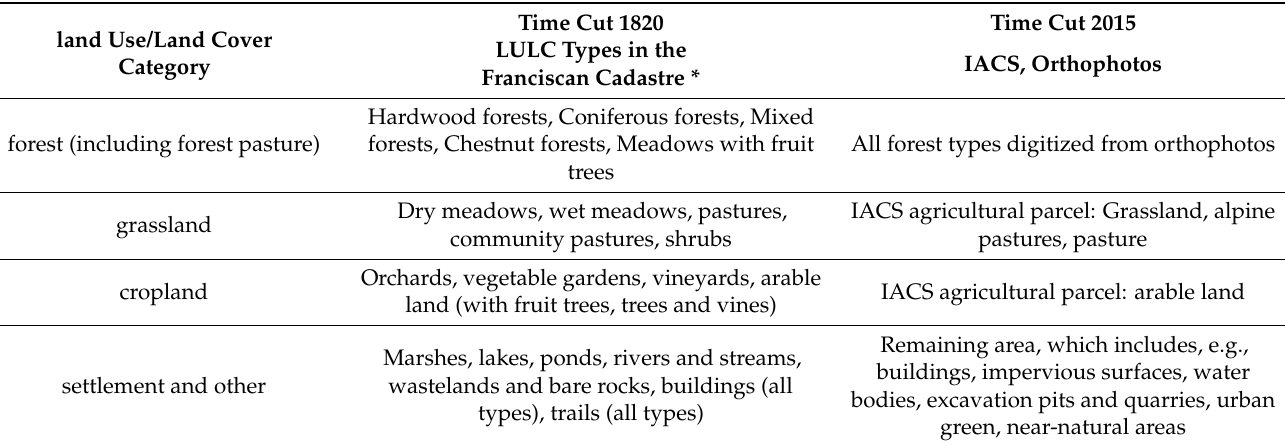
Table A2. Overview of the classification and recording of land use classes according to time cut.